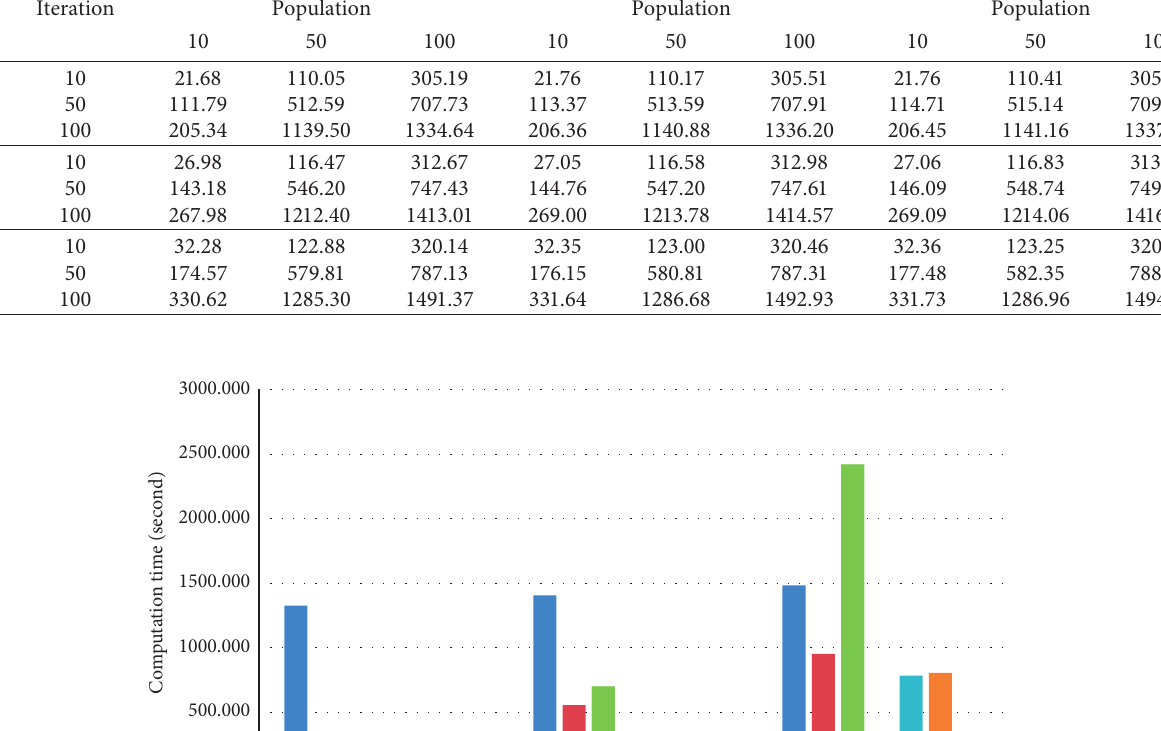
Table 5: Results of the comparison between varied parameters and speed towards computation time (seconds). V